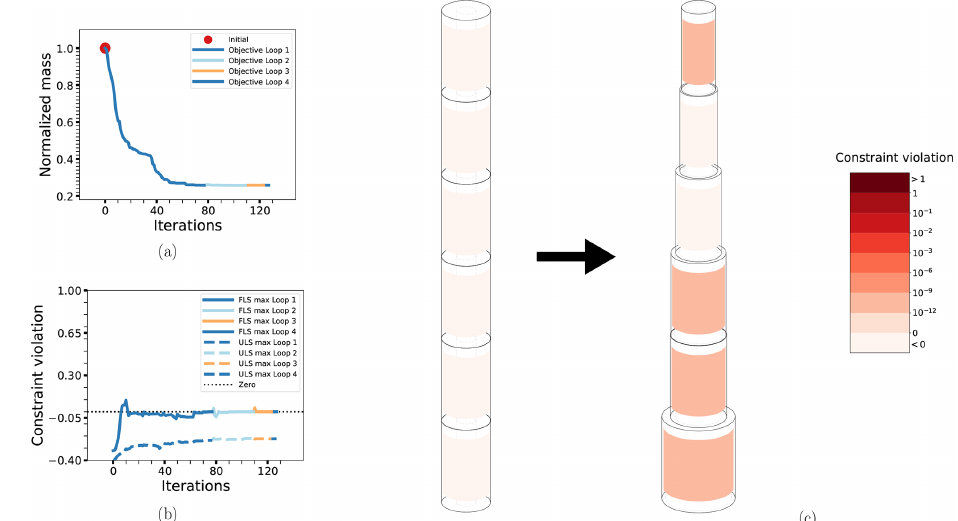
Figure 8. The optimization process for case BEAM-PA: the objective function (a) , maximum non-linear constraint violations (b) and the change in the design from initial to final configuration (c) . Details as in previous figure.